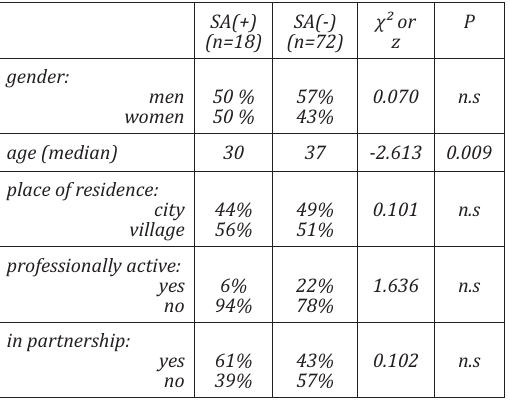
SA(+) SA(-) χ² or P (n=18) (n=72) z